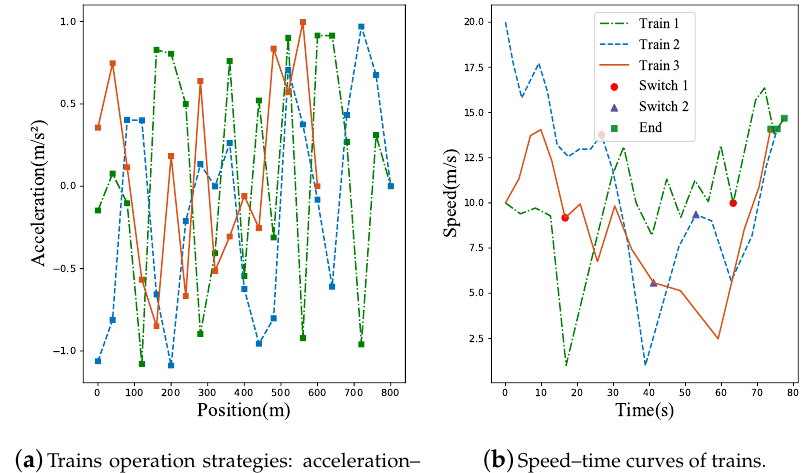
( b ) Speed–time curves of trains. Figure 7. Improved PSO strategies and operation curves in scenario 2.